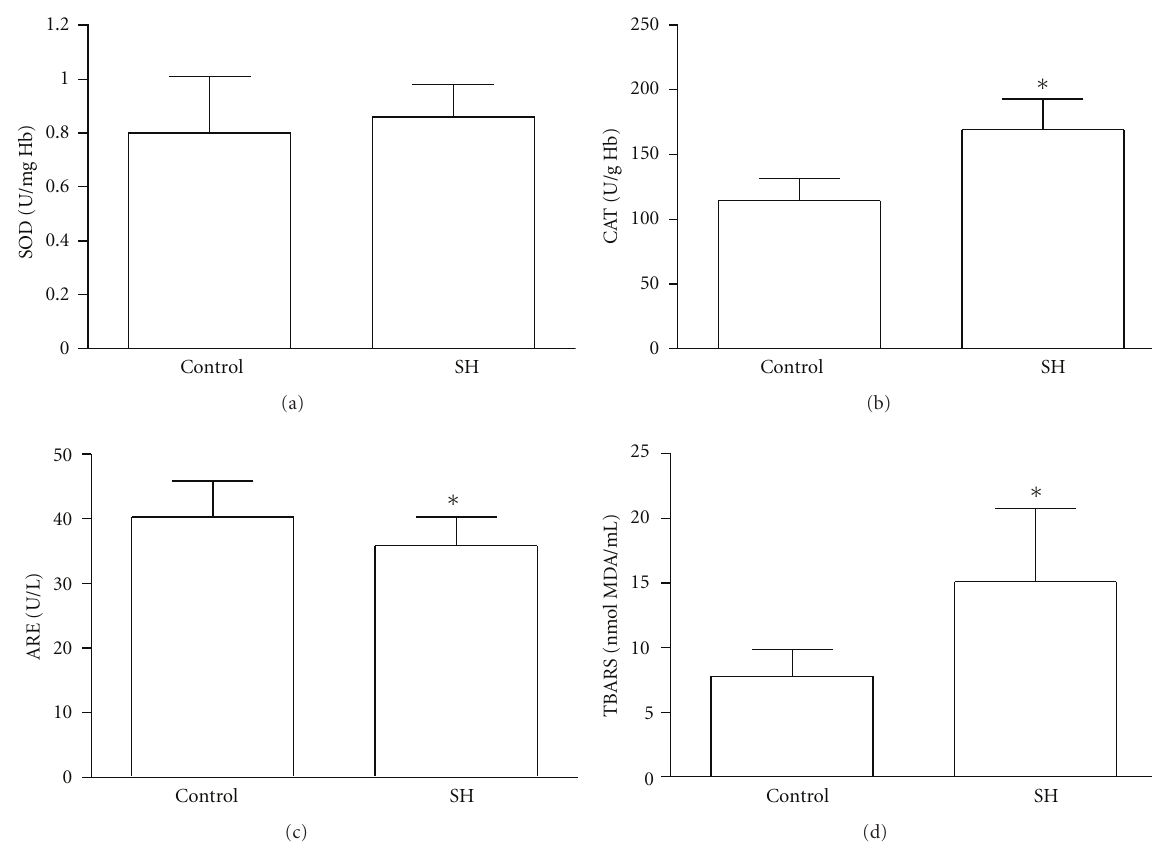
Figure 1: The values of SOD (a), CAT (b), ARE (c), and TBARS (d) in control and subclinical hypothyroidism (SH) groups. ∗ P < 0 . 05.